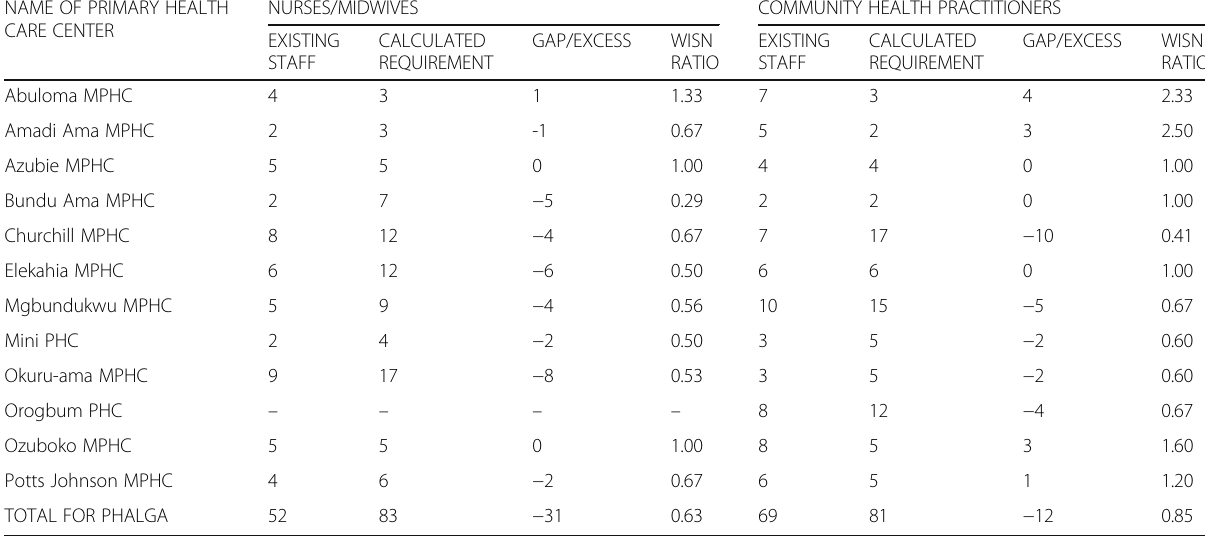
Table 5 Wisn results for nurses/midwives and community health practitioners for port harcourt city local government area (phalga) NAME OF PRIMARY HEALTH CARE CENTER